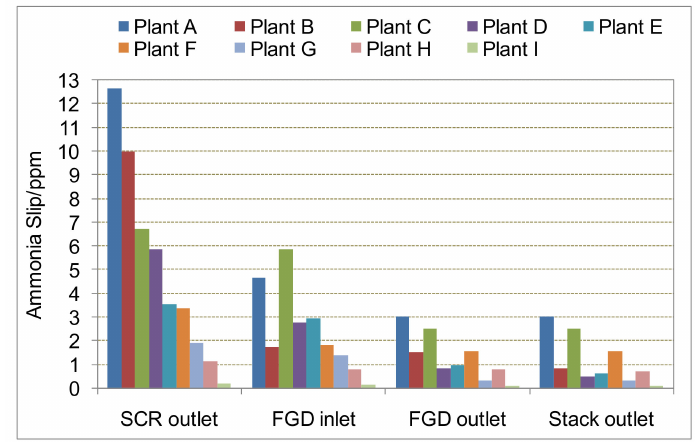
Figure 3. Site test result of the ammonia emission of Plant